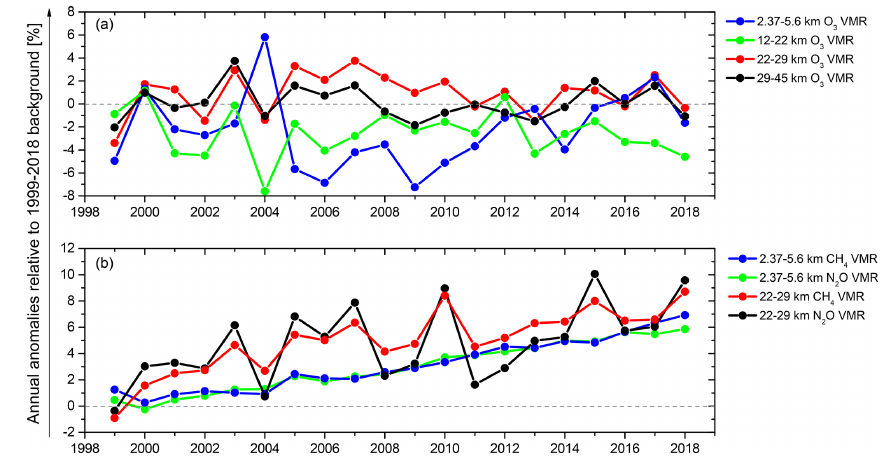
Figure 11. Time series of annual anomalies relative to the 1999-2018 background (in %) for NDACC VMR means of (a) O 3 (2.37–5.6, 12–22, 22–29, and 29–45km layers) and (b) CH 4 and N 2 O (2.37–5.6 and 22–29km layers). Annual anomalies are computed according to temporal decomposition as detailed in Appendix